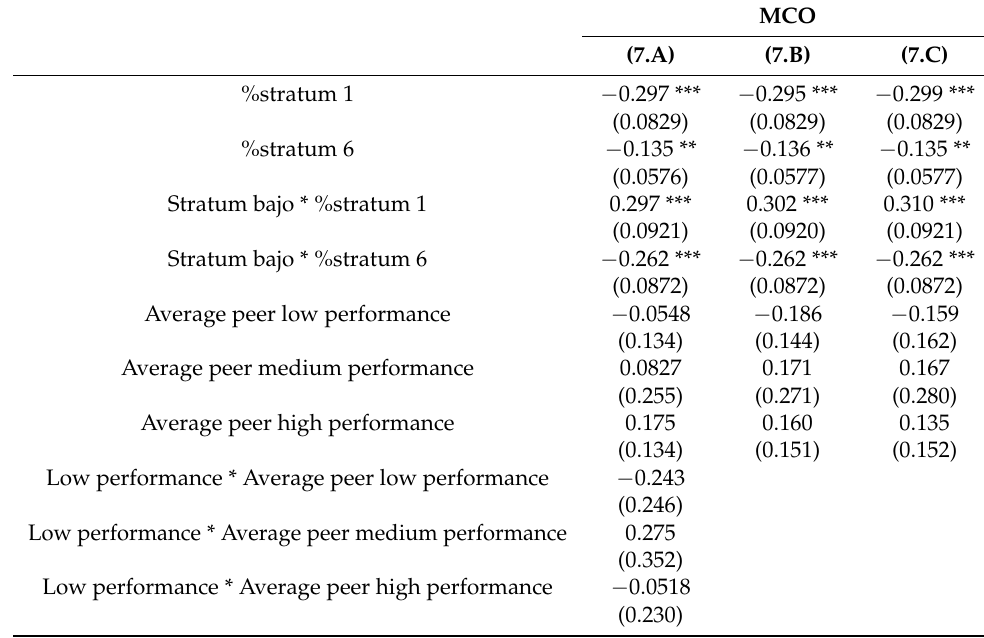
Table A7. Effects of heterogeneous peers according to student’s academic performance in Communi- cation Skills